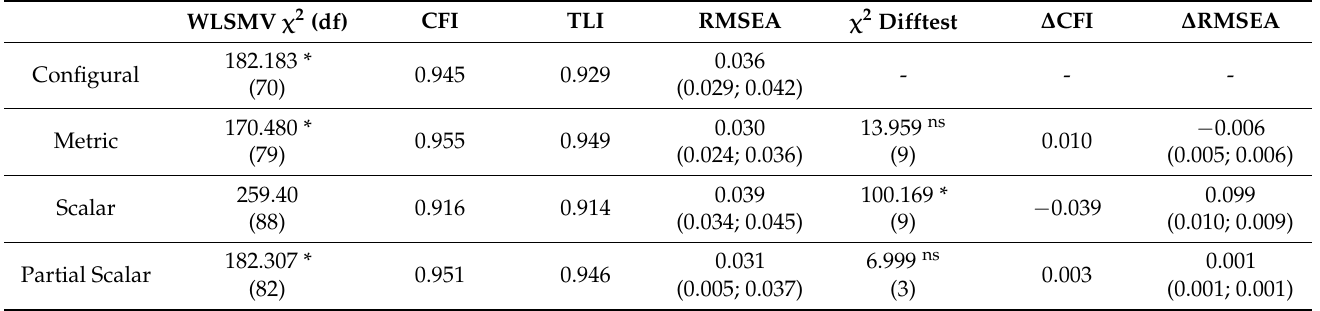
Table 4. Fit indices for multi-group confirmatory factor analyses and difference